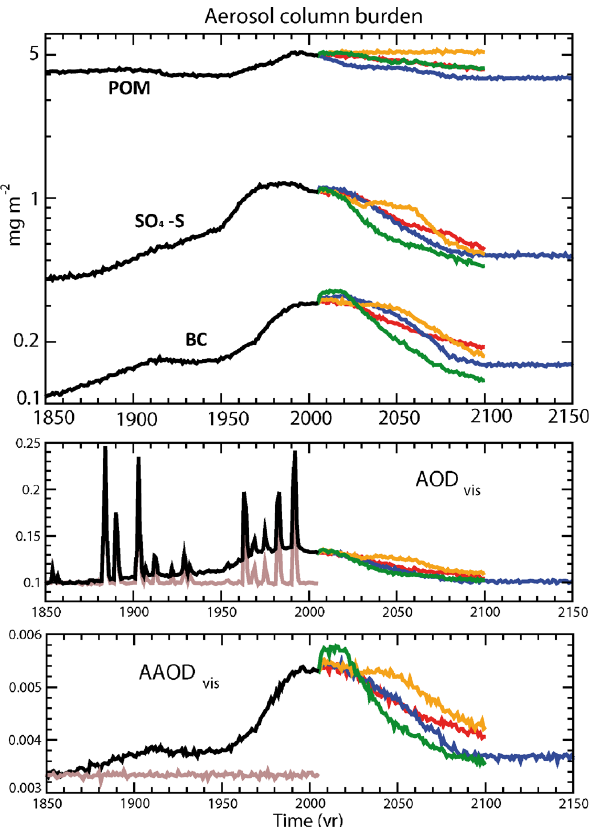
Fig. 2. Globally and annually averaged aerosol column burdens for particulate organic matter (POM), particulate sulphate as S (SO 4 -S), and black carbon (BC) (upper panel), aerosol optical depth (AOD) (middle panel), and aerosol optical depth for absorption (AAOD) (lower panel) from 1850 onwards, calculated online in NorESM1- M. Curves for Historic1 from 1850 to 2005 are black. For scenario projections, green are RCP2.6 for 2005–2100, blue are RCP4.5 for 2005–2300 (negligible variations after 2150), orange are RCP6.0 for 2005–2100, and red are RCP8.5 for 2005—2100. The brown curves are contributions to AOD and AAOD in Historic1 by natu- ral aerosols only, including prescribed stratospheric sulphate from explosive volcanoes.